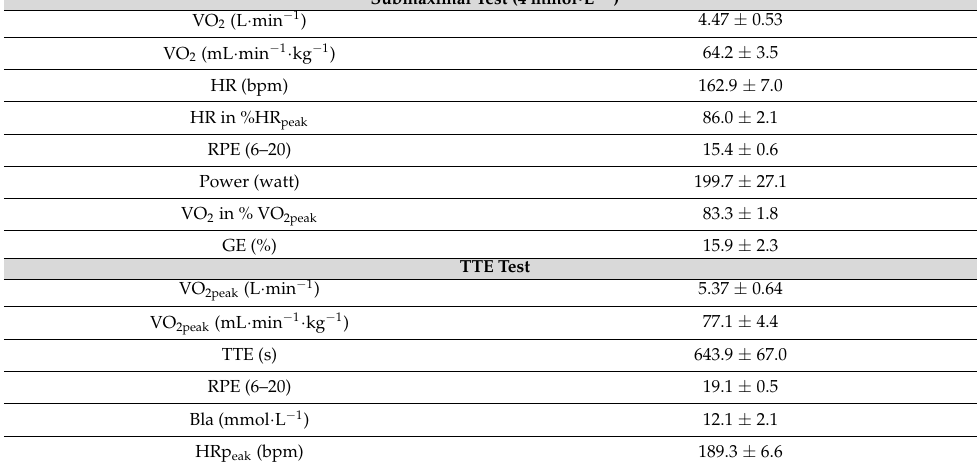
Table 5. Laboratory-based data from a submaximal blood lactate profile and time to exhaustion test during roller-ski skating in fourteen national-level male cross-country